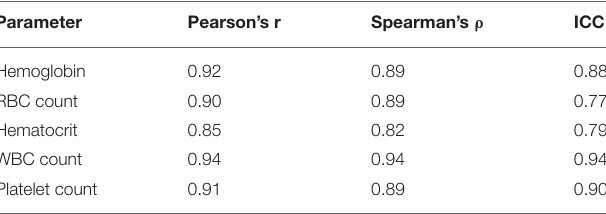
TABLE 3 | Correlation coefficients for hematological parameters measured in capillary and venous blood; p < 0.01 for all